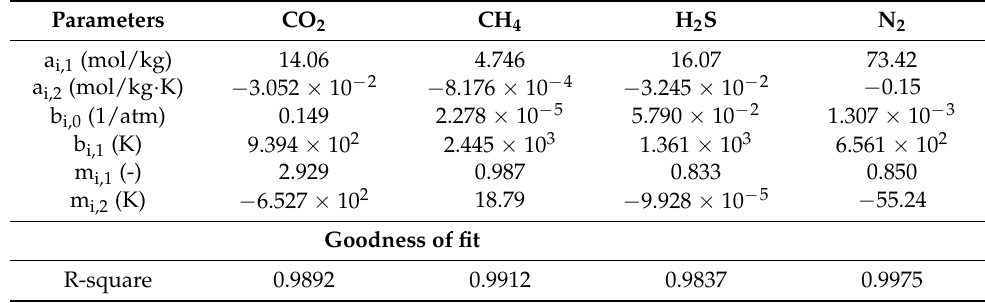
Table 10. Parameters in Langmuir–Freundlich isotherm for COSMO zeolite